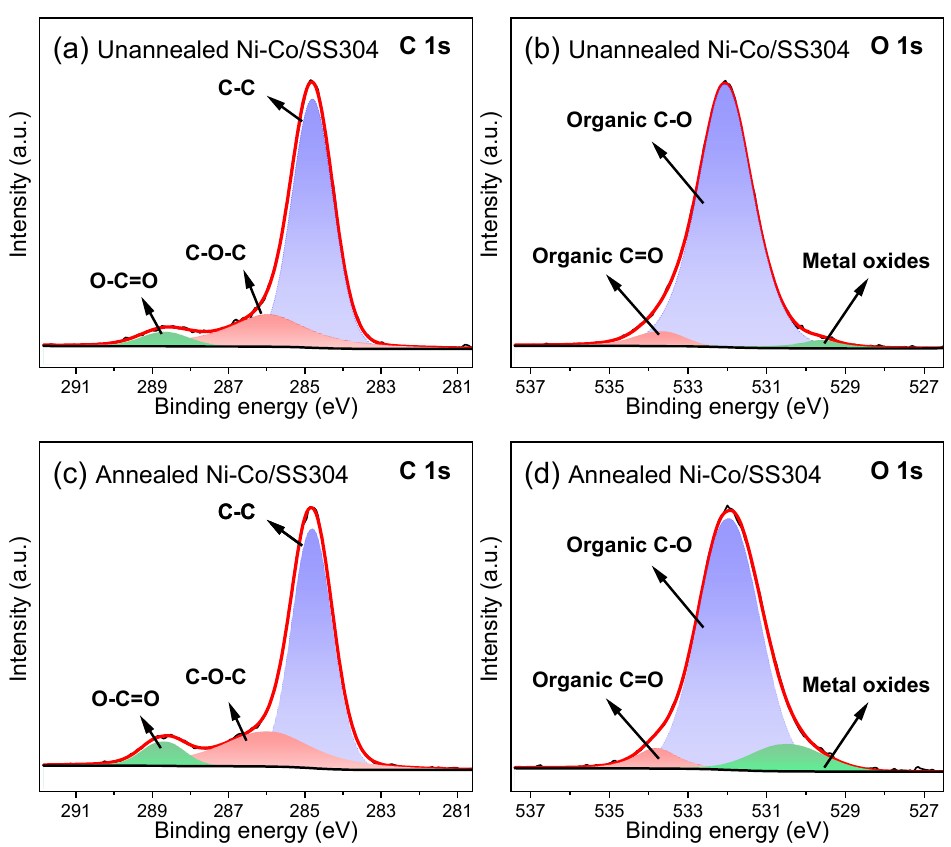
Figure 6. XPS spectra of C 1s and O 1s of Ni–Co/SS304: ( a , b ) unannealed; ( c , d ) annealed.